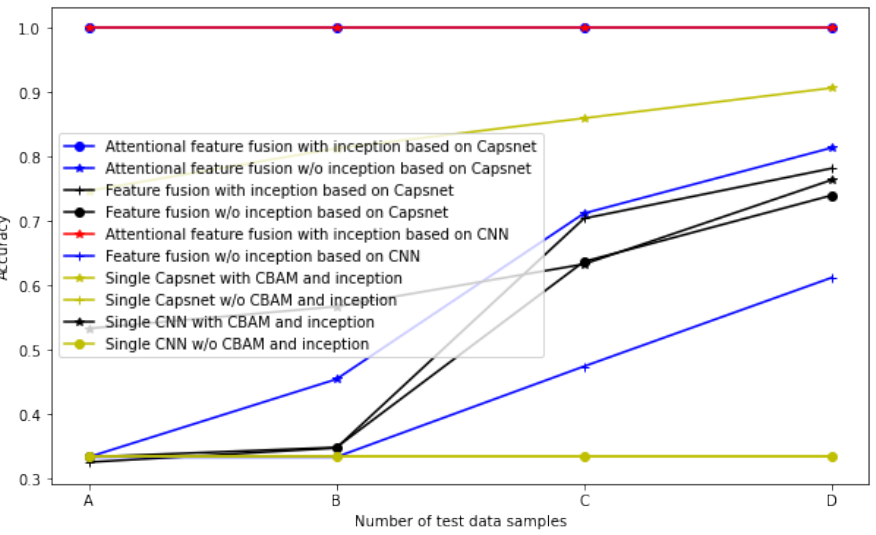
Figure 10. The diagnosis accuracy of different diagnosis methods on four datasets.